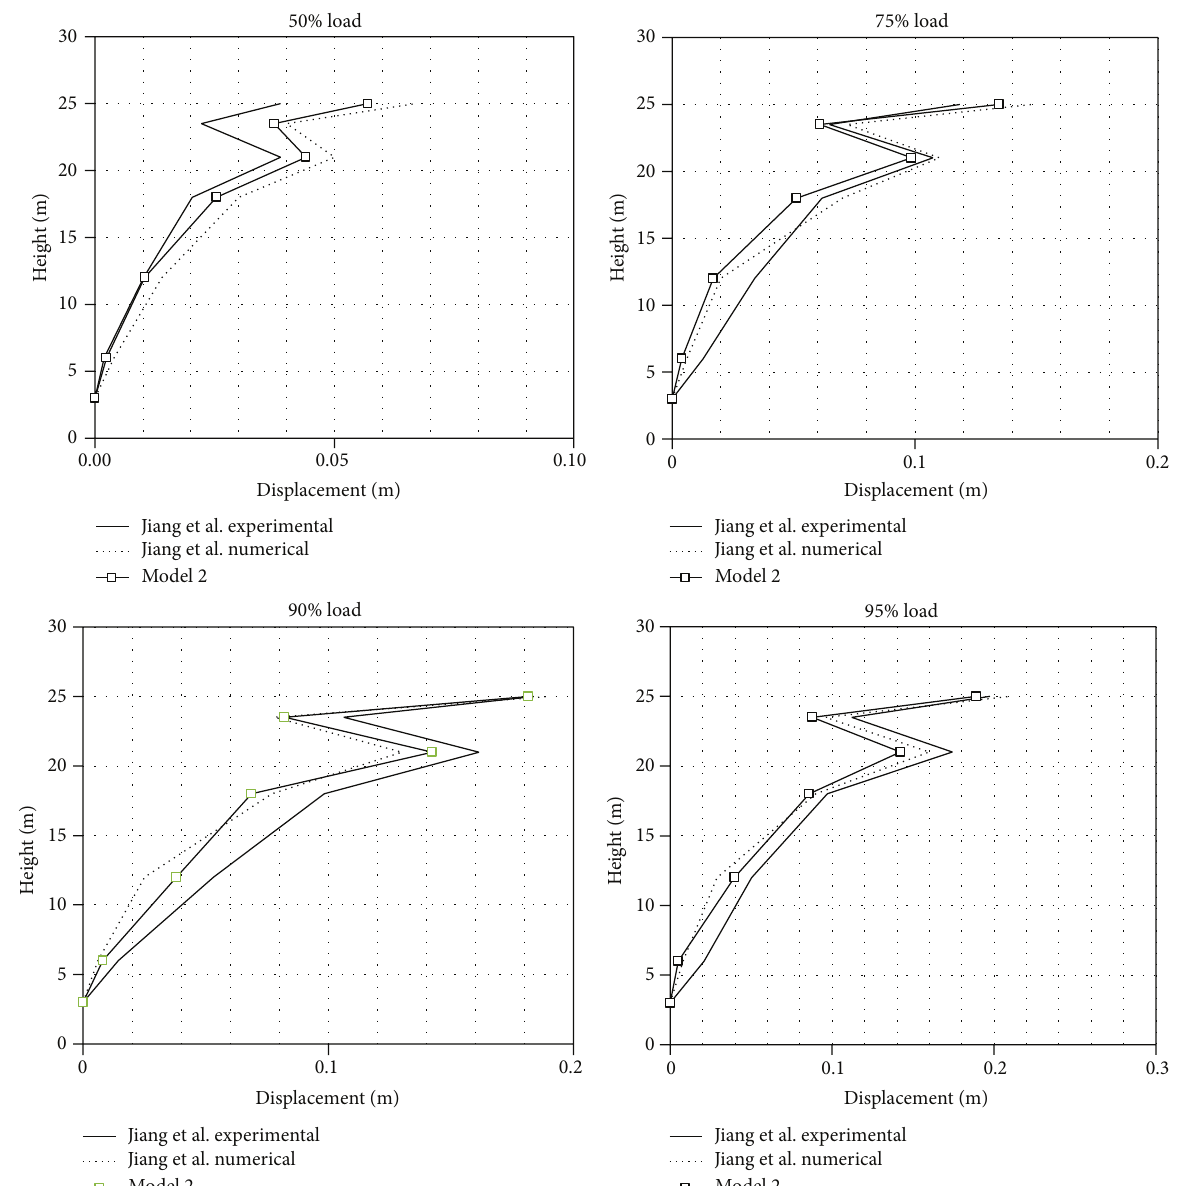
Figure 19: Tower 2 longitudinal displacement at maximum